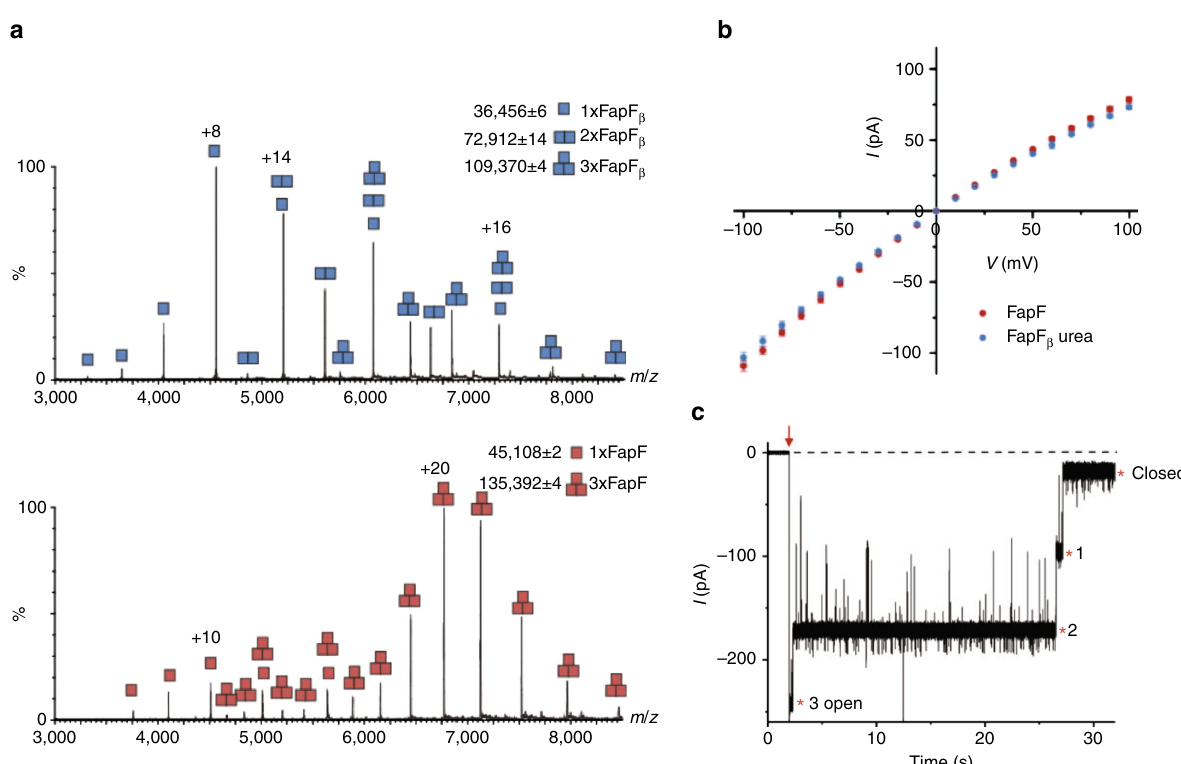
Fig. 2 Native mass spectrometry analysis and single-channel electrophysiology of FapF. a The oligomeric state of FapF β (data shown in blue ) and full-length FapF (data shown in red ). b I – V curves for the full-length FapF ( red , n = 11) and FapF β ( blue , n = 6) reconstituted into planar DPhPC bilayers. The curves display mean unitary conductance values ( ± s.d.) from − 100 mV to +100 mV in 0.1 M KCl, 20 mM potassium phosphate buffer, pH 7.0. FapF β required the addition of 4 M urea to the recording chamber, which presumably unfolds the plug to enable insertion of an open channel. The urea was exchanged with fresh buffer before measuring conductance. c Single-channel gating trace of full-length FapF. At an applied potential of − 250 mV ( red arrow ), full-length FapF gated in three equal steps (marked with an asterisk ) which is indicative of a trimer. The dashed line